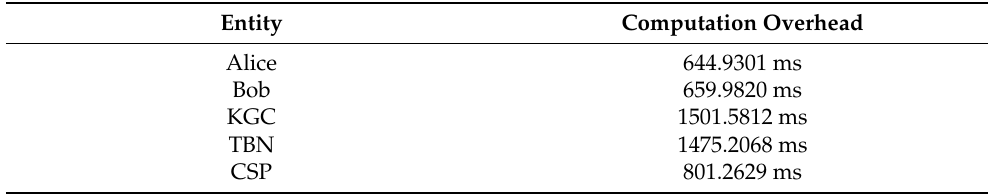
Table 4. Computation overhead of pseudonym mechanism based on IBS.